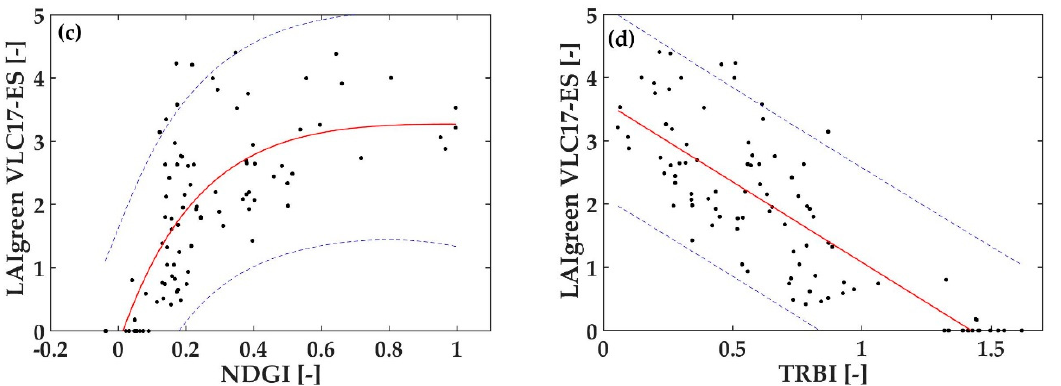
Figure 5. Graphic representation of the LAI green of VLC17_ES dataset as a function of the established LAI green indices, with the best fitting function and 95% of confidence interval. ( a ) RI [41]; ( b ) NDGI [43]; ( c ) NDGI [42]; ( d ) TRBI [61].